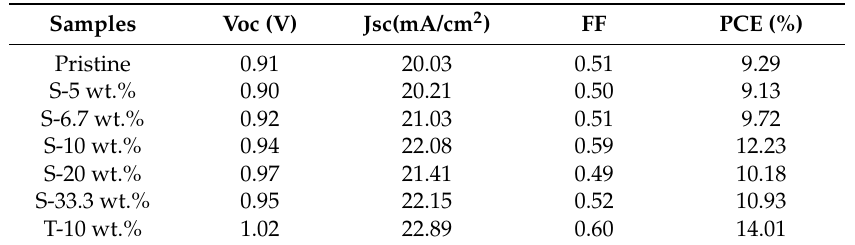
Figure 4. ( a ) The energy level diagram of the PSCs; ( b ) density–voltage (J–V) curves of PSCs at various wt.% concentrations of Ag NPs. Table 1. Photovoltaic performances summary of the perovskite devices.